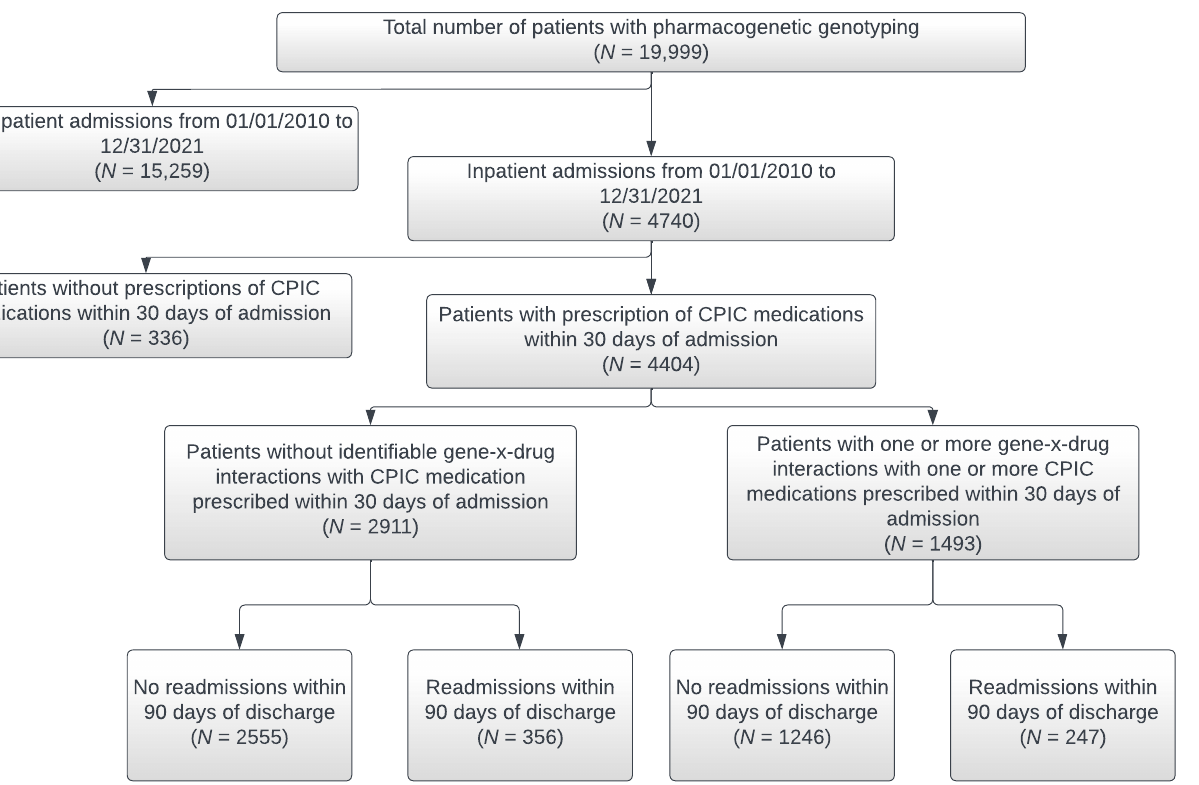
Figure 1. Flow Diagram of Patient Selection for Analyses.